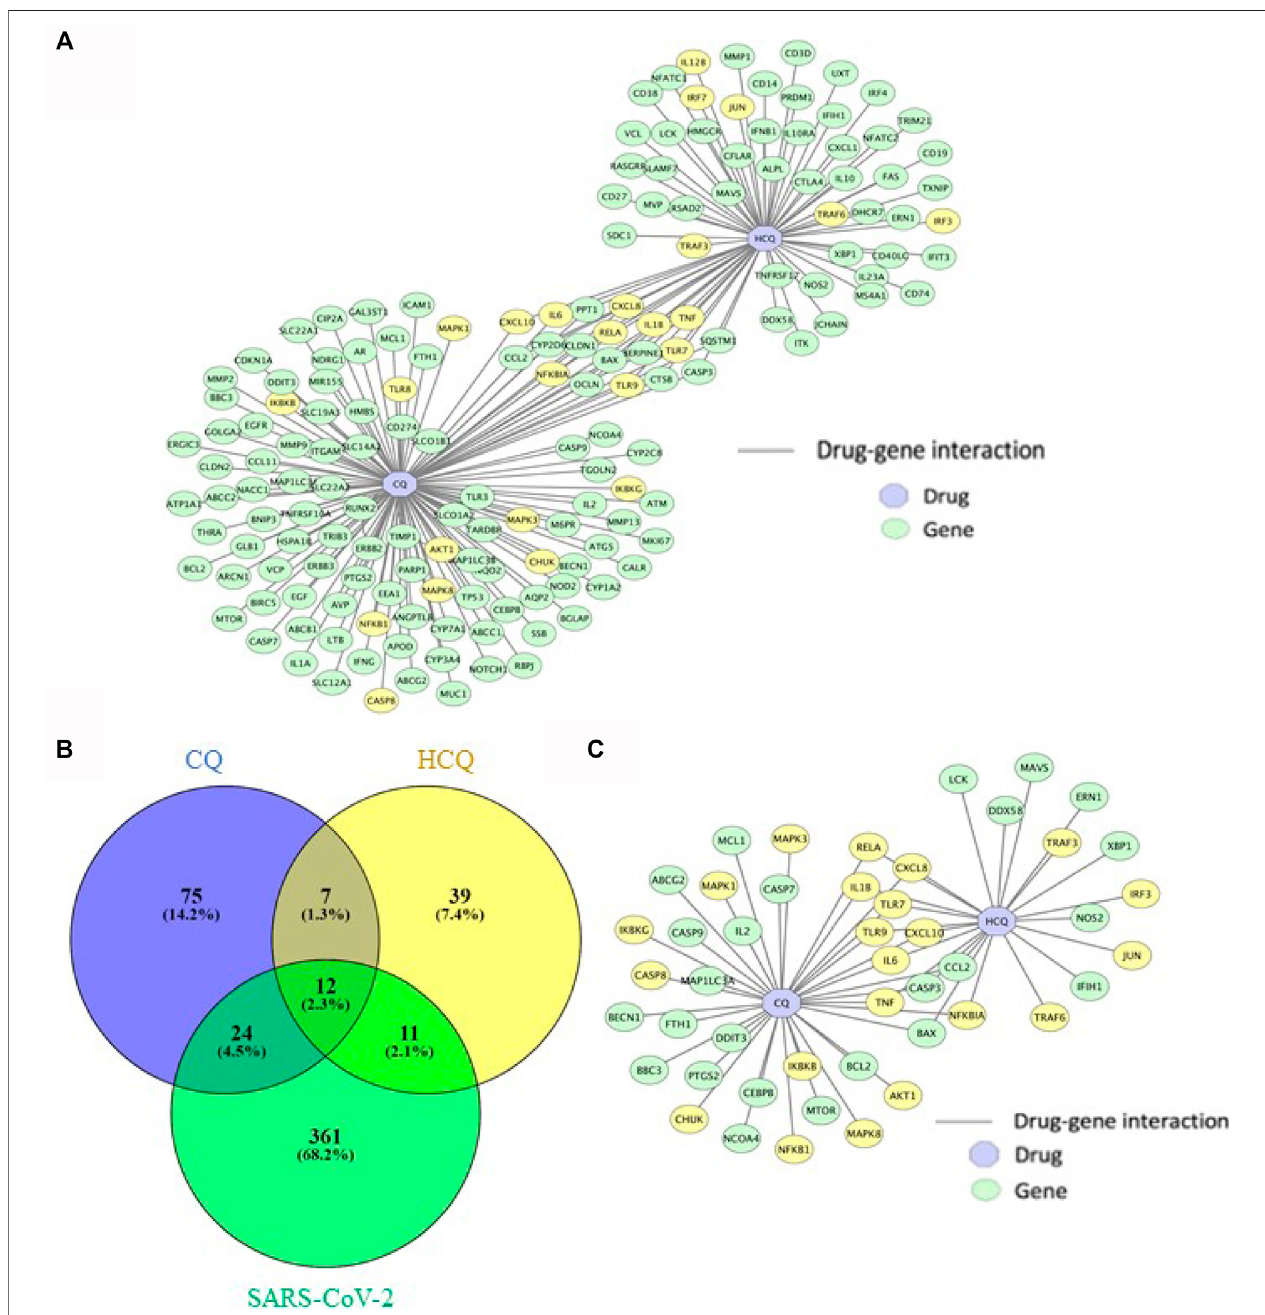
FIGURE2| Thecharacterizationofdrug-gene interactionnetworkbetweenCQ,HCQ, andgenetargets. (A) Gene interaction networkbetweenCQand HCQ was constructed on Cytoscape. Blue node: drug. Green node: gene. Yellow node: gene in enriched pathways (TLR9 and IL-6 signaling pathways). (B) A Venn Diagram visualizingoverlapbetweenthegenetargetsofCQ(blue),HCQ(yellow),andSARS-CoV-2network(green).47overlappedgenetargetswereidenti fi edasCQ/HCQgene targets of SARS-CoV-2. (C) The 47 overlapped gene targets were incorporated to construct a drug-gene interaction network on Cytoscape. Blue node: drug. Green node: gene. Yellow node: gene in enriched pathways (TLR9 and IL-6 signaling pathways).